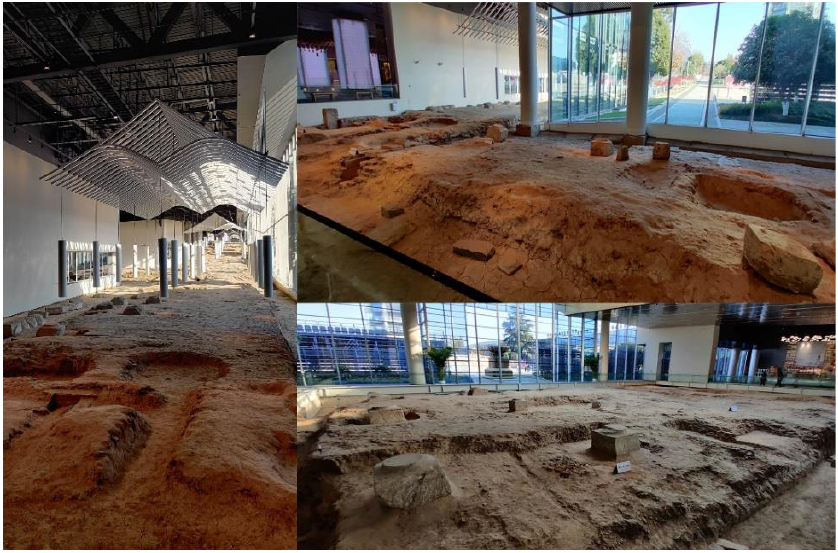
Figure 6. The ruins of the Great Bao’en Temple on display (Source: photo courtesy of Pengfei